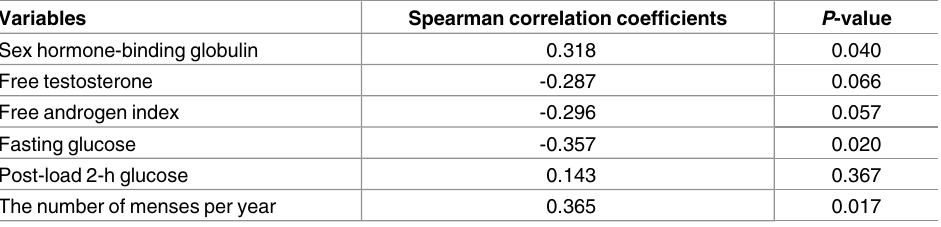
Table 3. Correlation analysis between the relative expression of miRNA-6767-5p and reproductive/ metabolic variables in total subjects.